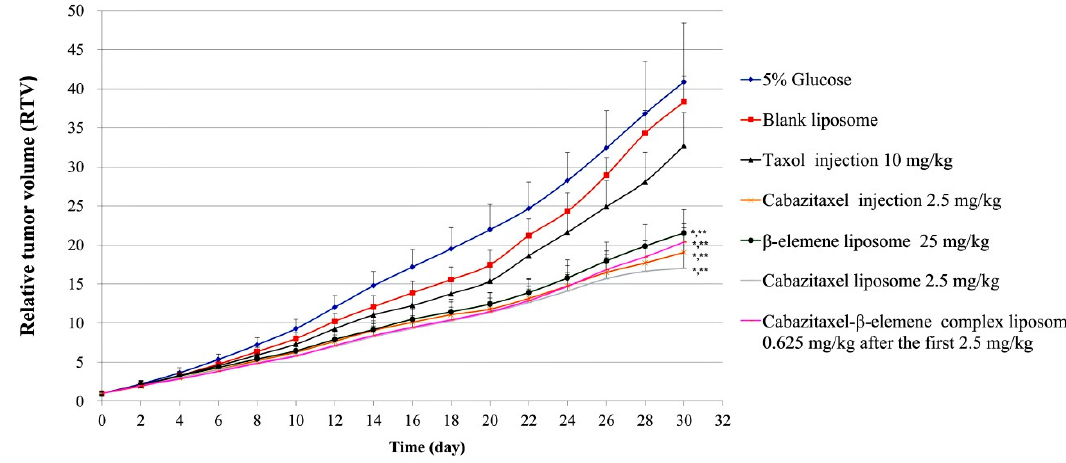
Figure 2. Relative tumor volume profiles of studied liposomes. *Compared with the 5% glucose group, there was a statistically significant di ff erence ( p < 0.01). Compared with 5% glucose group, the statistics parameter of cabazitaxel injection was t = 7.682, p < 0.01; that of the β -elemene liposome group was t = 7.221, p < 0.01; that of cabazitaxel liposome was t = 8.012, p < 0.01, that of the cabazitaxel- β -elemene complex liposome was t = 8.612, p < 0.01. **Compared with the taxol injection group, there was a statistically significant di ff erence ( p < 0.01). Compared with the taxol injection group, the statistics parameter of cabazitaxel injection was t = 7.373, p < 0.01; that of the β -elemene liposome group was t = 6.369, p < 0.01; that of the cabazitaxel liposome was t = 7.469, p < 0.01; and that of the